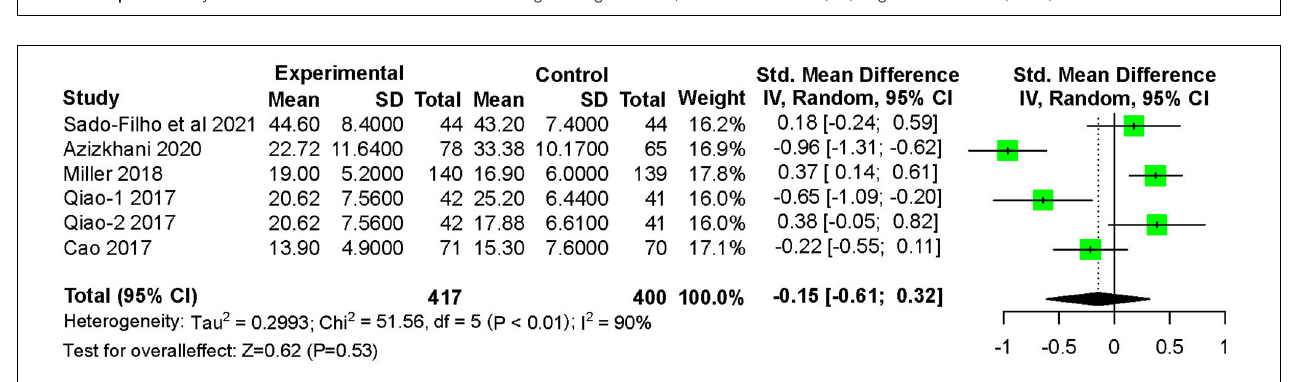
FIGURE 8 | Meta-analysis of nebulized dexmedetomidine for emergence agitation. CI, confidence interval; df, degress of freedom; M-H, Mantel-Haenszel.